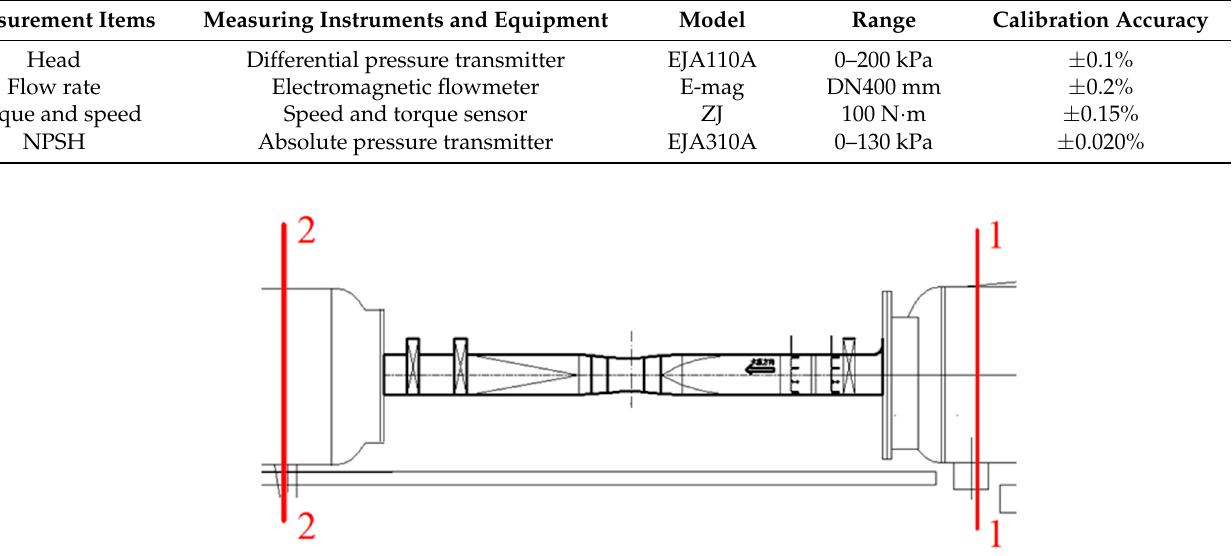
Table 2. Basic geometric parameters of the pumping device.